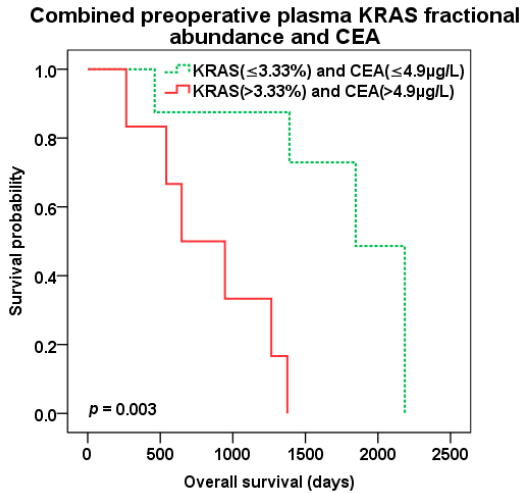
Figure 8. Overall survival (OS) after liver surgery for patients with combined low (green color dotted line) vs. high (red color) preoperative KRAS pFA and CEA levels (cut-off 3.33% and 4.9 µg/L, resp.).